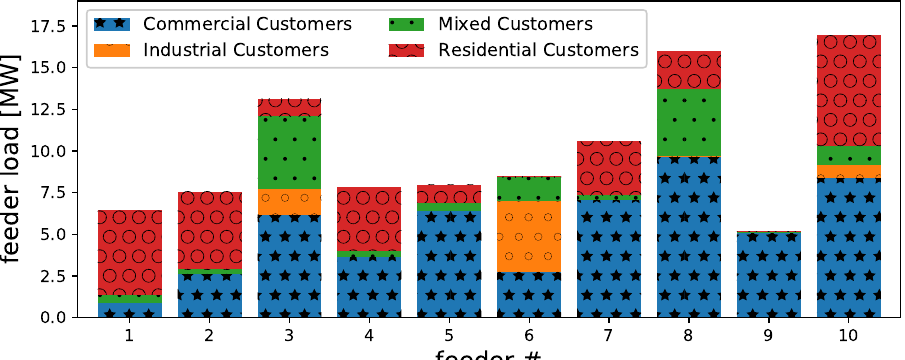
Figure 2. Each feeder had various levels of commercial, industrial, mixed, and residential loads. The power profiles were normalized to a common mode, which allowed for the comparison of feeders of the same type but different magnitudes, using Equation (1)